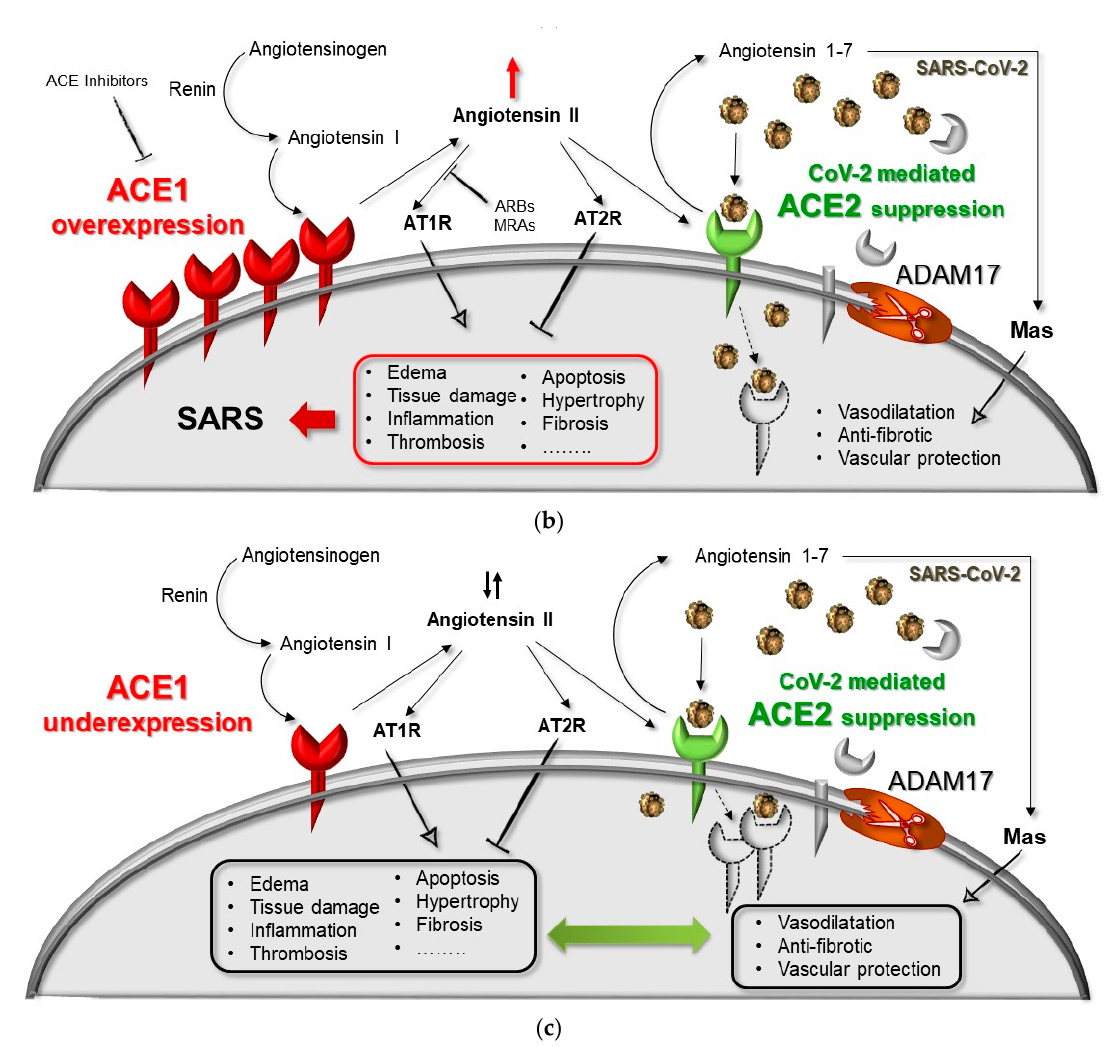
Figure 3. Hypothesized mechanism of a genetic–environmental interaction between ACE1 / ACE2 genes and SARS-CoV-2 infection. ( a ) Normal-health condition with a balanced RAS, normal Ang-II levels (Ang-II ↓↑ ), in the absence of virus infection. ( b ) Over-expression of ACE1 receptor as in the presence of the ACE1 DD-genotype (i.e., rs4646994, rs1799752, rs4340, rs13447447) in combination with ACE2 downregulation due to SARS-CoV-2 infection and / or in the presence of the ACE2 8790 G-allele (i.e., rs2285666), resulting in ACE1 / ACE2 unbalancing, RAS over-activation (Ang-II ↑ ) and lung shut-down. ( c ) Under-expression of ACE1 receptor as in the presence of the ACE1 II-genotype (i.e., rs4646994, rs1799752, rs4340, rs13447447) in combination with ACE2 downregulation due to SARS-CoV-2 infection counteracted by the ACE2 8790 A-allele (i.e., rs2285666), resulting in ACE1 / ACE2 re-balancing, no RAS over-activation, re-balanced Ang-II levels (Ang-II ↓↑ ), and no lung shut-down. ADAM17: metallopeptidase domain 17; ARBs: angiotensin receptor blockers; MRAs: mineralocorticoid receptor